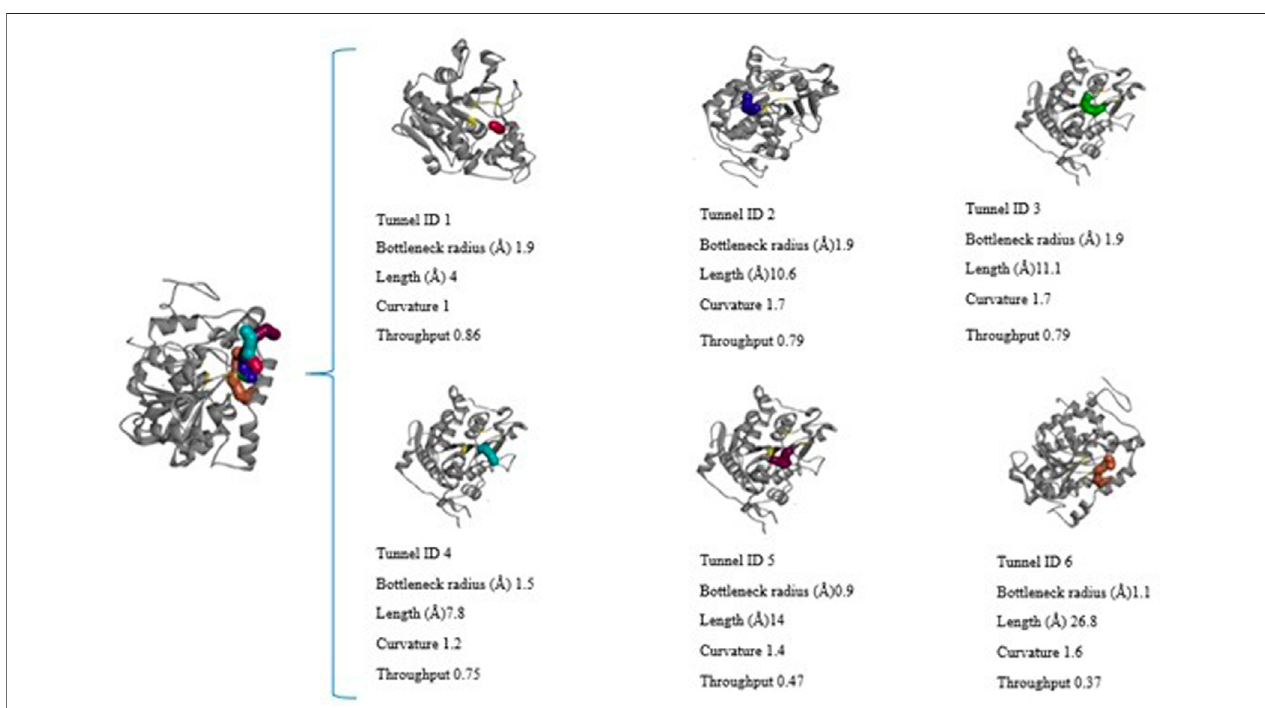
FIGURE3| Graphicalrepresentation oftheCALB crystallographicstructure (PDB:5A6V)ingray,inyellowthe locationoftheactive site, andthevisualizationofthe 6 access tunnels in different colors that compose it, obtained in Caver Web and visualized in Discovery Studio, and the characteristics of tunnel size (Å), Length (Å), curvature, and the throughtput (possibility of